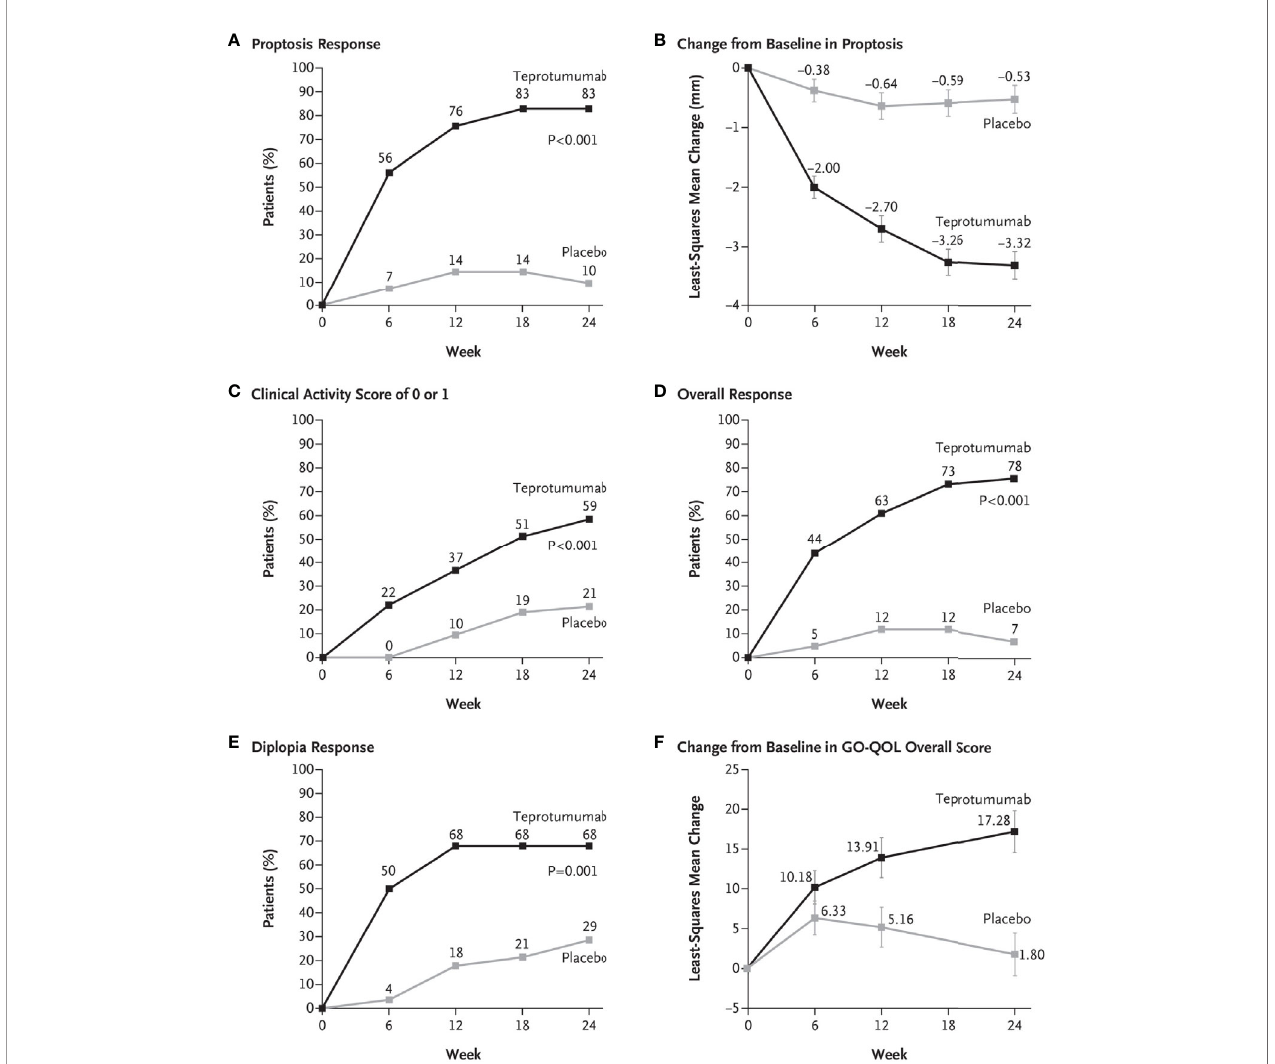
FIGURE 6 | (A) Proptosis responder analysis (percent of patients with ≥ 2 mm reduction in proptosis from baseline in study eye). (B) Change from baseline in proptosis (least squares mean ± standard error). (C) Percent of patients with clinical activity score (CAS) of 0 or 1 in study eye. (D) Overall responder rate (percent of patients with ≥ 2-point reduction in CAS and ≥ 2 mm reduction in proptosis from baseline in study eye). (E) Diplopia response (percent of patients with improvement of at least 1 grade from baseline). (F) Change from baseline in transformed GO-QOL score (least squares mean ± standard error). From N. Engl. J. Med,